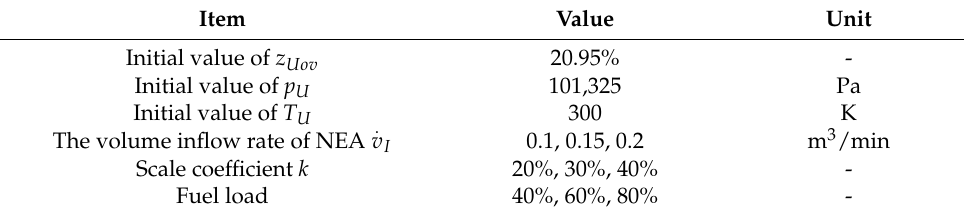
Table 4. Initial states and understudied ranges of the controlled parameter of ullage washing.